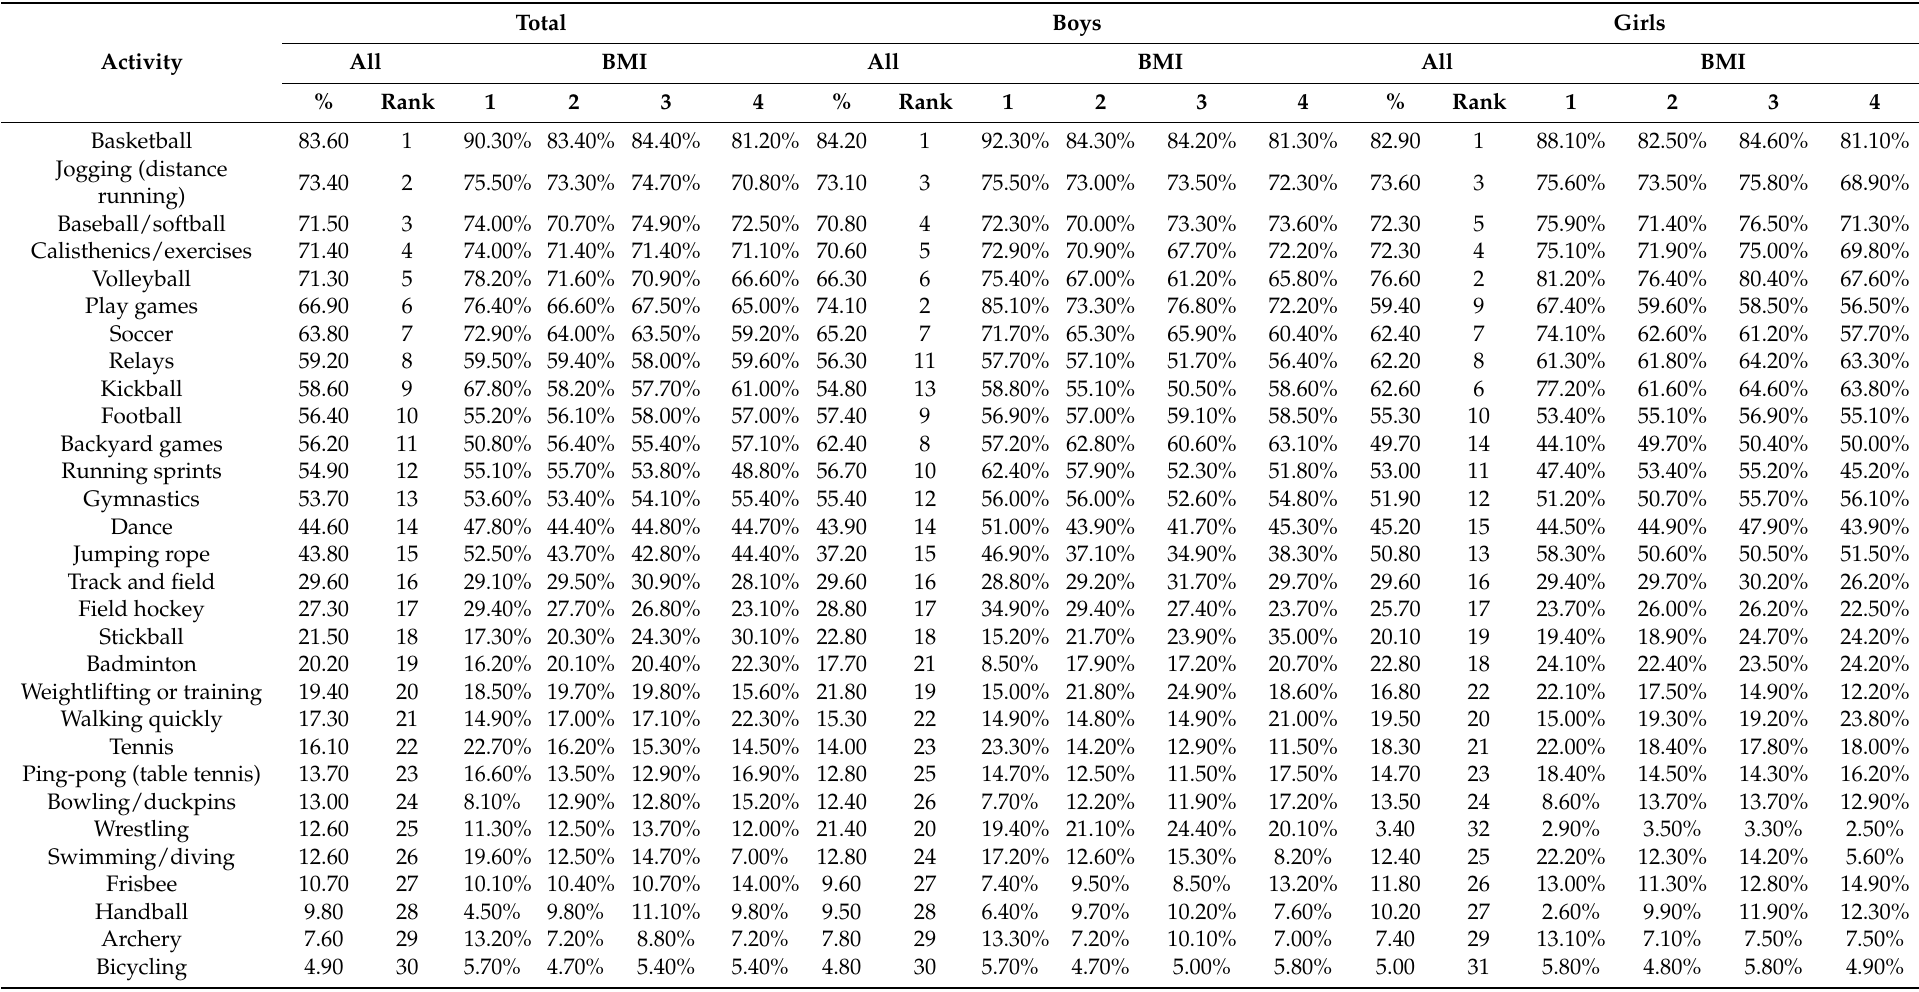
Table 2. Ranking of physical activities in school physical education (PE) in 1985 (Body mass index (BMI): 1 = Underweight, 2 = Normal weight, 3 = Overweight, 4 =